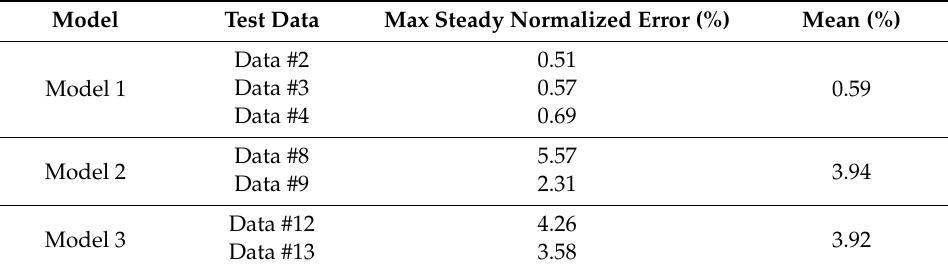
Table 3. Normalized error of trained models.